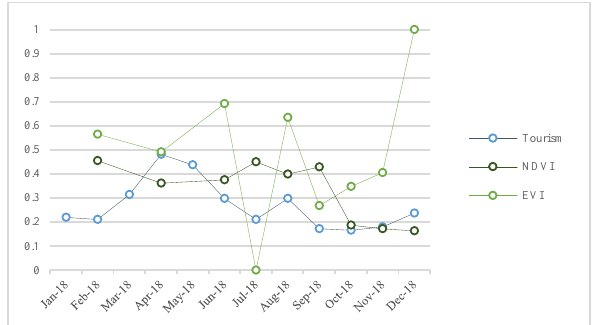
Figure 7. Time Series of Tourist influx vs NDVI and EVI values in